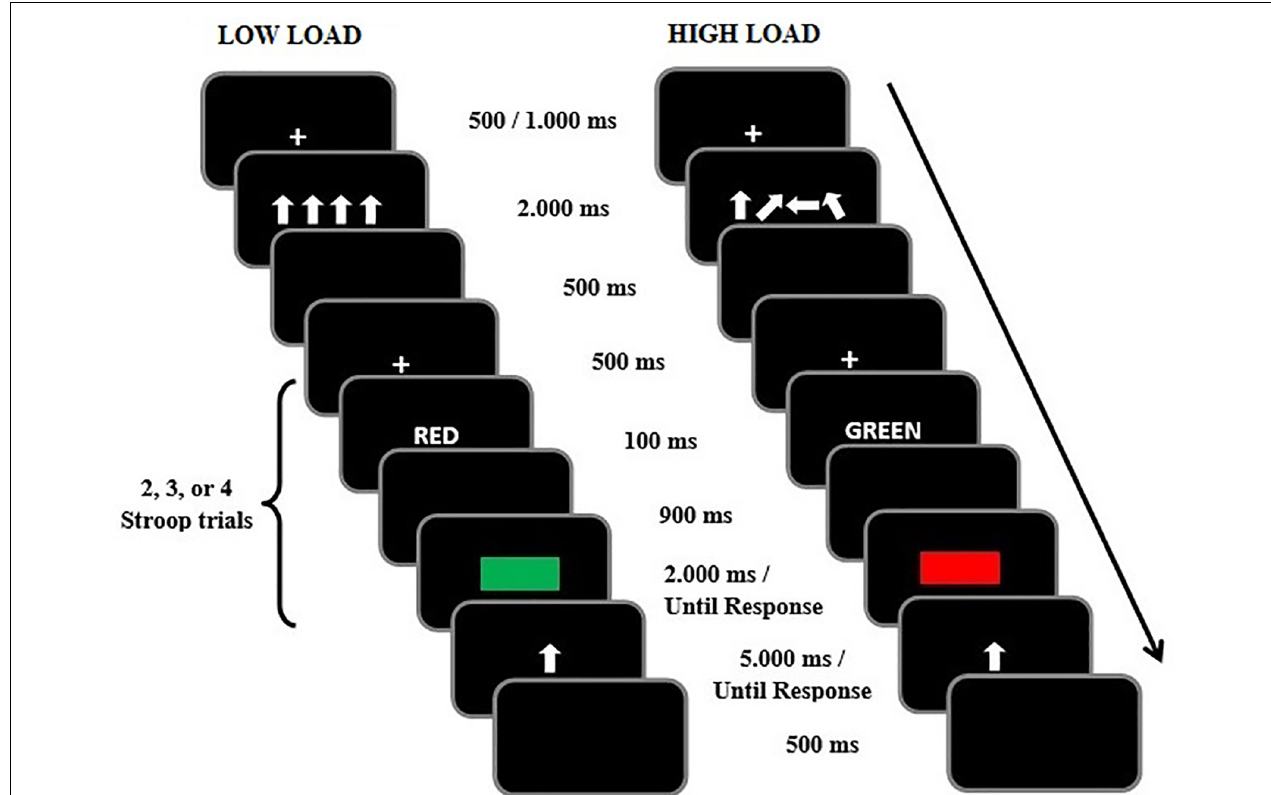
FIGURE 2 | Examples of incongruent trials in the Stroop task under low (Left) and high (Right) working memory load in Experiment